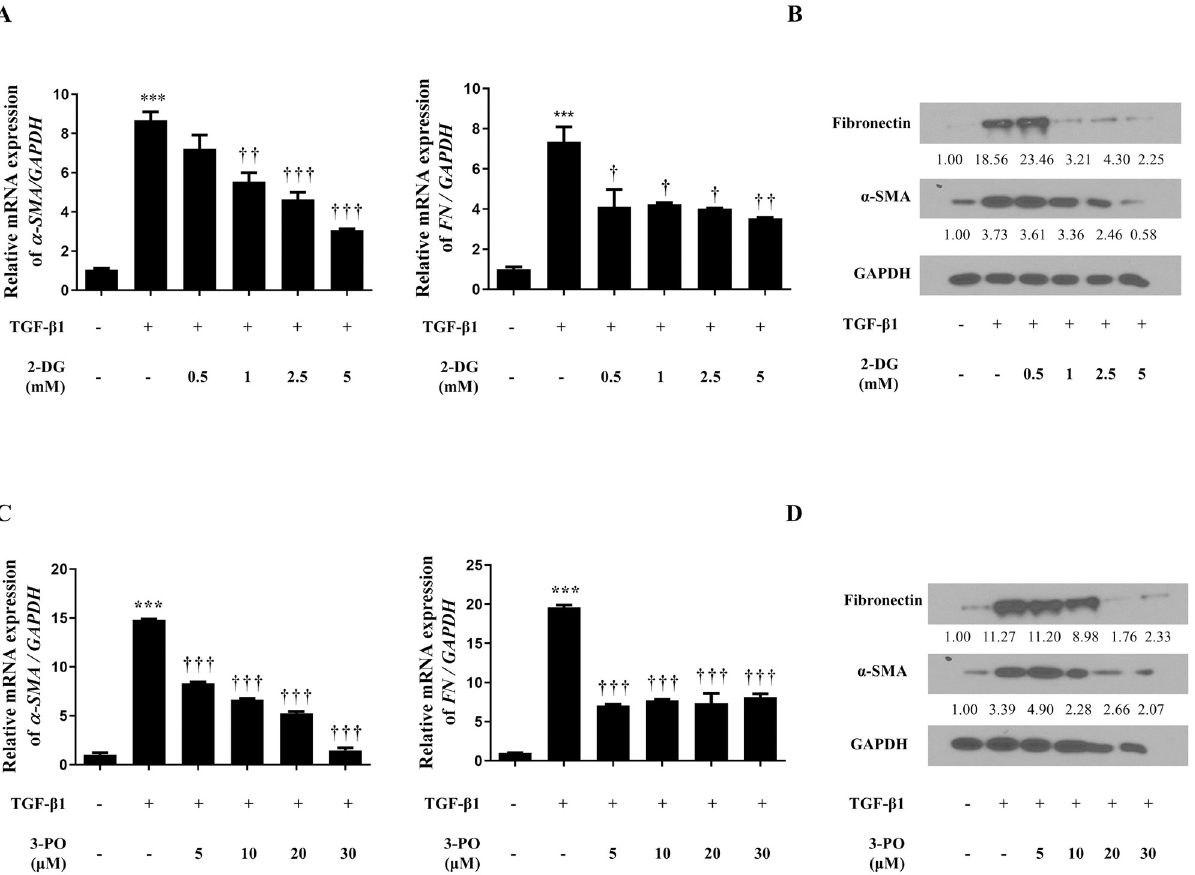
Fig 2. 2-Deoxy-D-glucose (2-DG) and 3-(3-pyridinyl)-1-(4-pyridinyl)-2-propen-1-one (3-PO) downregulated α -SMA (SMA) and fibronectin expression in TGF- β 1-treated nasal fibroblasts. (a, c) Gene expression of α -SMA and fibronectin was confirmed by RT-PCR; and (b, d) protein levels were detected by Western blotting. ��� p < 0.001 compared with control by one-way ANOVA test, †p < 0.05, ††p < 0.01, †††p < 0.001 compared with TGF- β 1 using one-way ANOVA test.